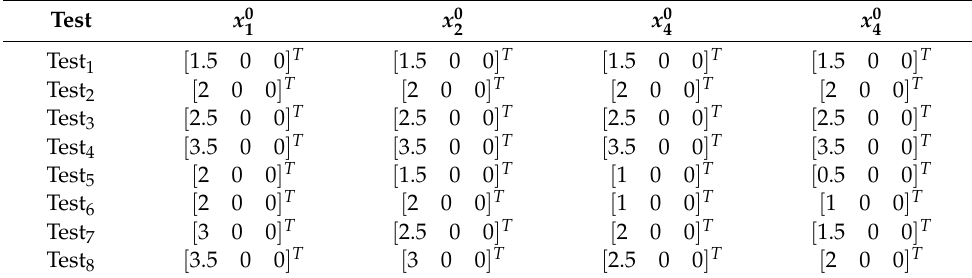
Table 1. Initial states values.